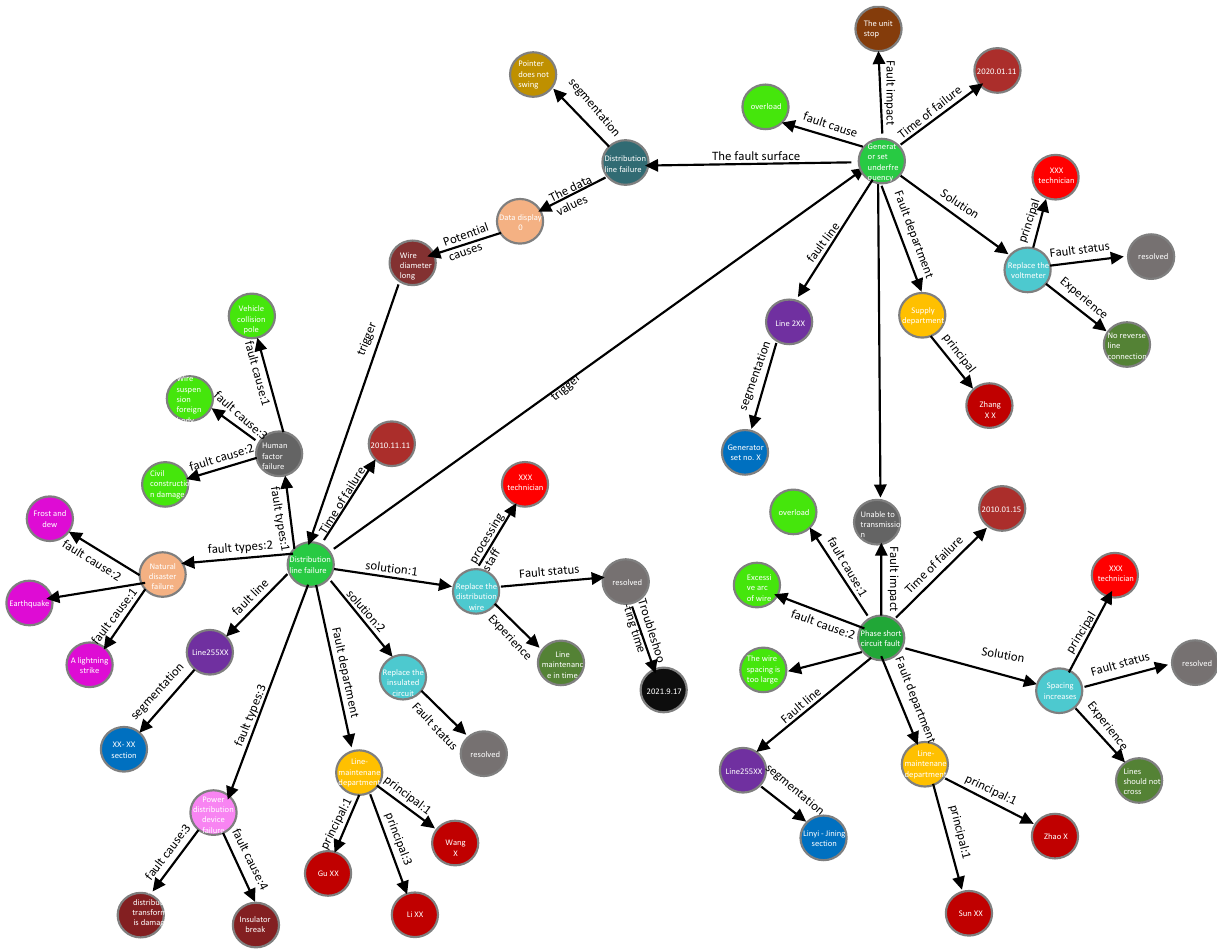
Figure 9. Power system fault diagnosis knowledge graph (part). When the power system fails the supervisory control and data acquisition system (SCADA) collects the fault information (such as fault phenomena, abnormal indicators, fault impact, etc.), analyzes the collected fault information, obtains a detailed fault report, and uses the relevant model of this article to analyze the report content into entity-relationship- entity form of triplet information. The corresponding triplet information is obtained, and then the Cypher query statement in the graph database Neo4j is used to find the matching triple information. If present, it returns the type of failure and the corresponding disposition information. If the matching triplet information is not located in the graph, a human expert analyzes the fault type, combines the power system fault disposal manual, manually processes and organizes the relevant empirical measures to form the corresponding triple, and stores it in the graph database Neo4j. The flow of applying the knowledge graph for troubleshooting is shown in the Figure